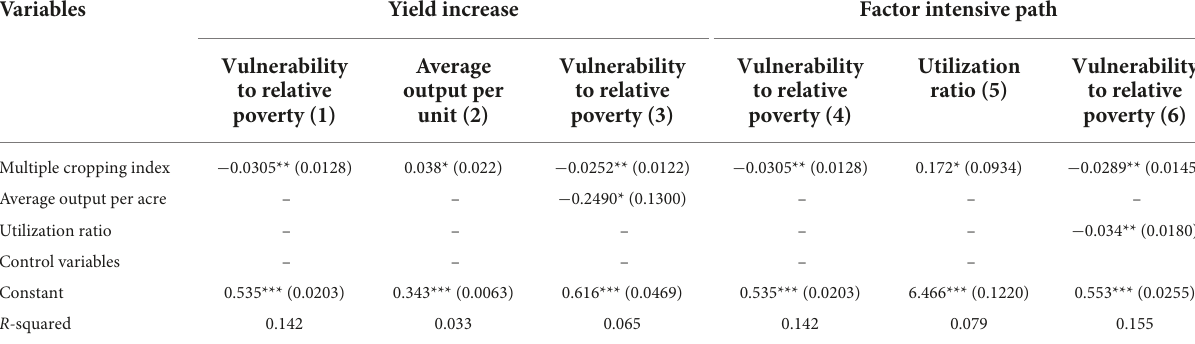
TABLE 7 The mechanism of multiple cropping on relative